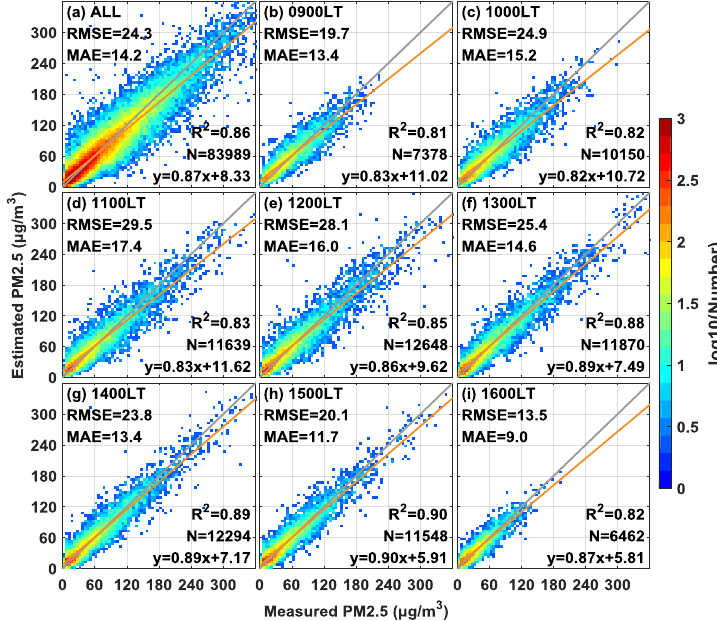
Figure 5. 10-fold cross-validation of estimated PM2.5 concentrations by comparing measured PM2.5 from all available data ( a ) and in different hours (0900–1600 local time) ( b – i ). The number of samplings (N), correlation coefficients (R), and linear regressions are included in the plot.